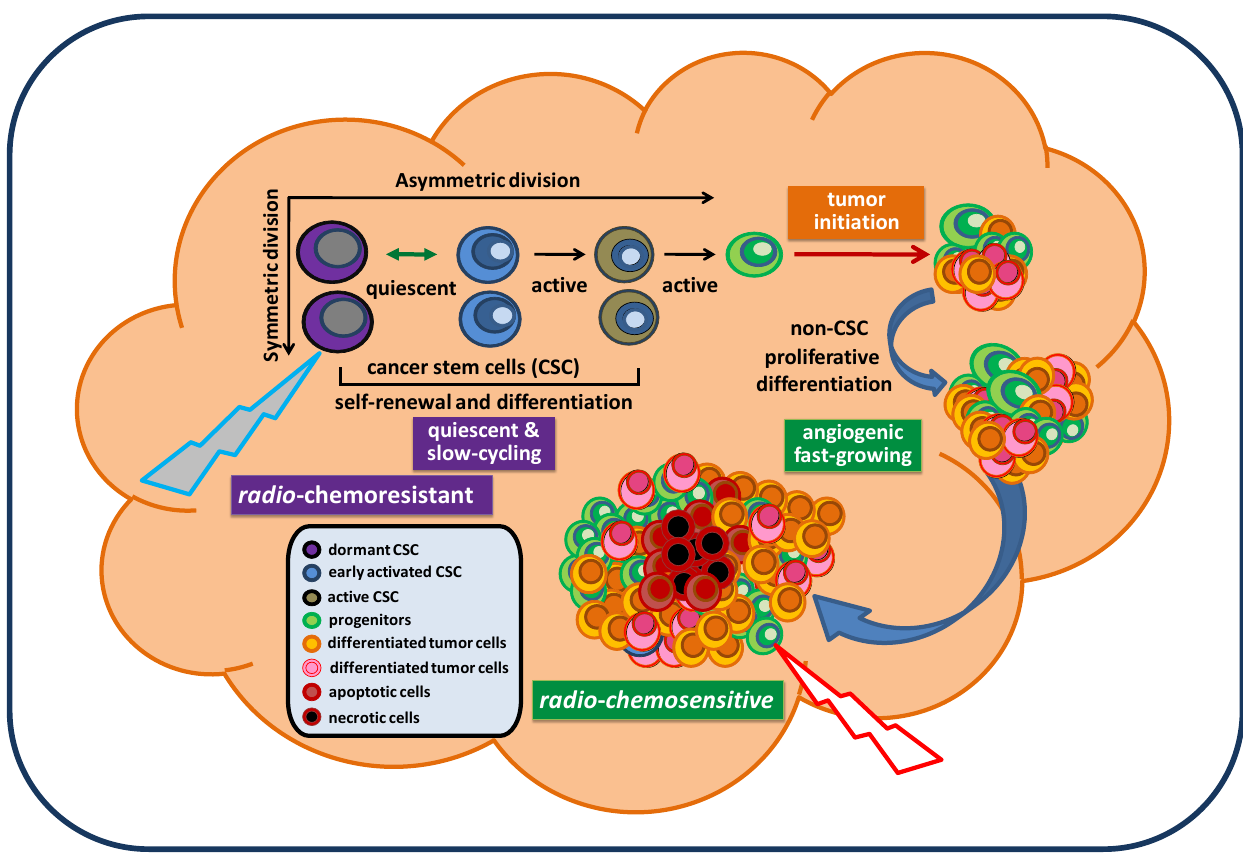
Figure 1. A theoretical model of a growing, treatment-resistant glioblastoma tumor. Glioblastoma stem cells (GSC) use both symmetric and asymmetric division to achieve sustained self-renewal and proliferative differentiation to initiate and maintain a tumor. GSC contain both quiescent and active cell types; the quiescent GSC are slow-cycling, poorly differentiated, radio-chemoresistant, and capable of unlimited self-renewal. The differentiated GSC progeny form a tumor containing a heterogeneous population in different states of differentiation, and are fast-growing, angiogenic, and radio- chemosensitive. GSC can escape from radio-chemotherapy and continually replenish tumor cells, leading to sustained